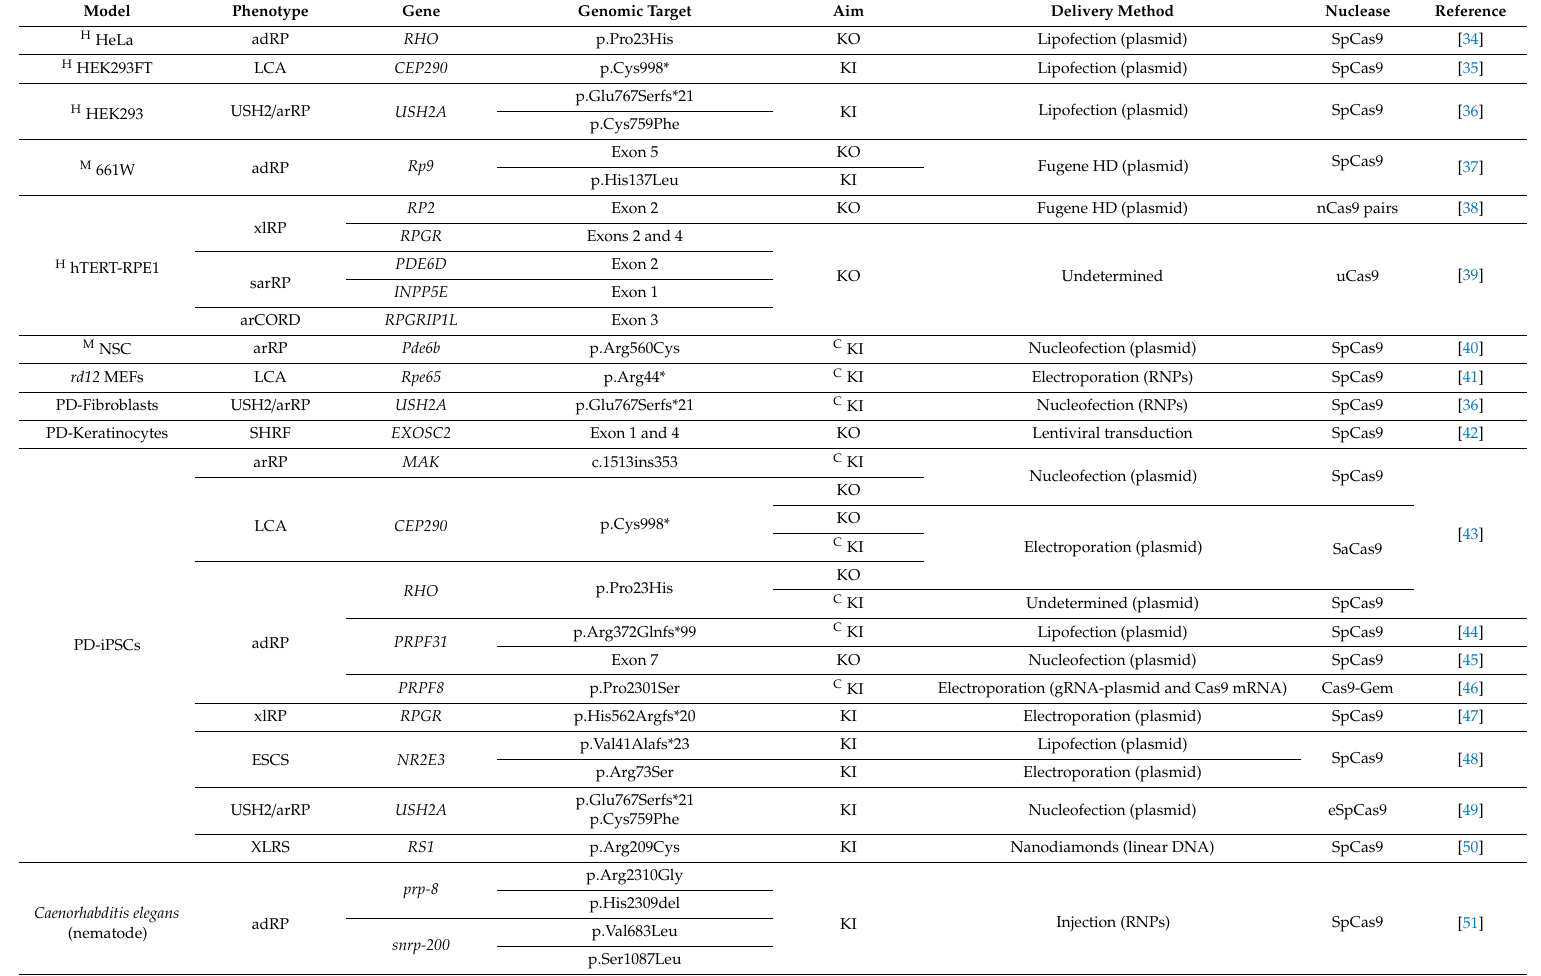
Table 1. Studies using the CRISPR technology for functional validation of variants of disease